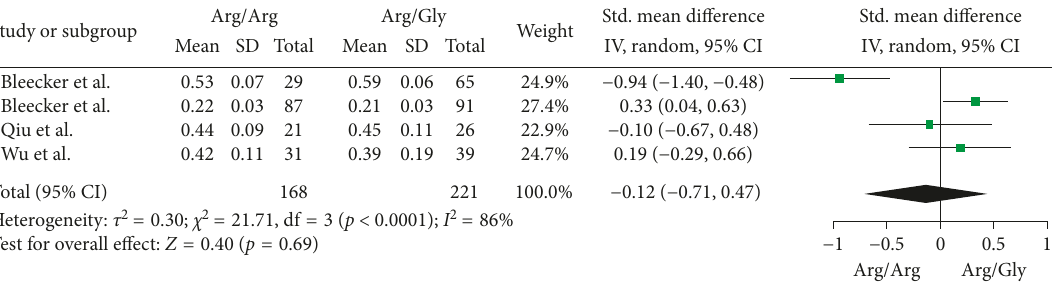
Figure 2: Forest plots of the association between the ADRB2 Arg16Gly polymorphism and pulmonary function response of inhaled ICS plus LABAs for asthma treatment (Arg/Arg or Arg/Gly) with 4 studies